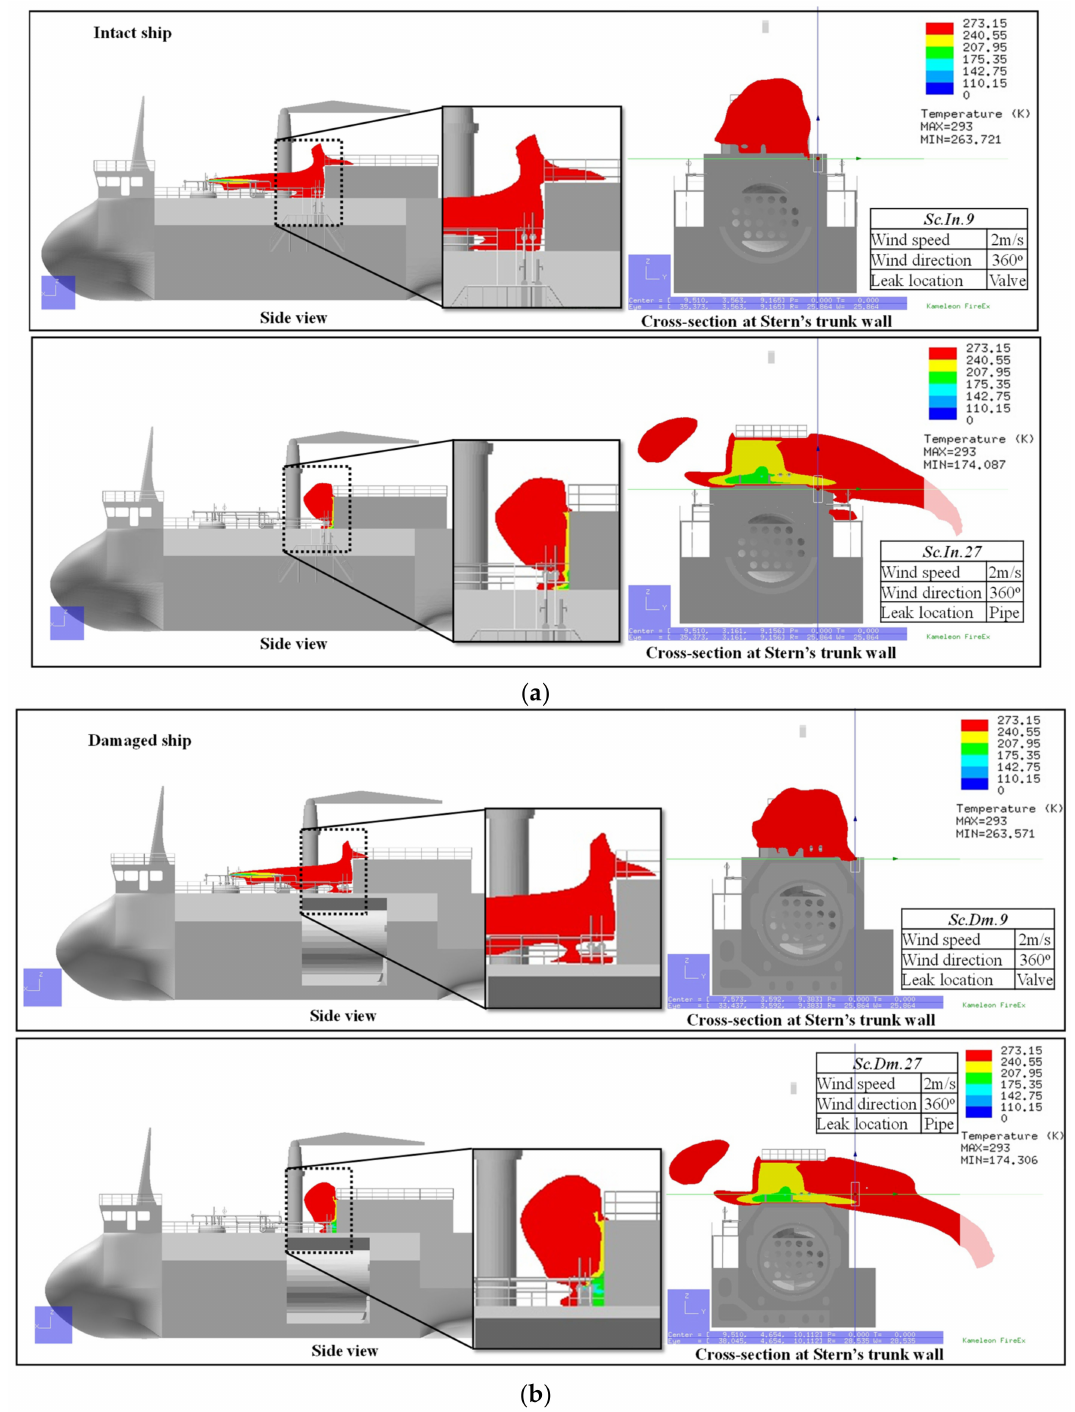
Figure 21. Plots of gas temperature: intact ( a ) and damaged ( b )